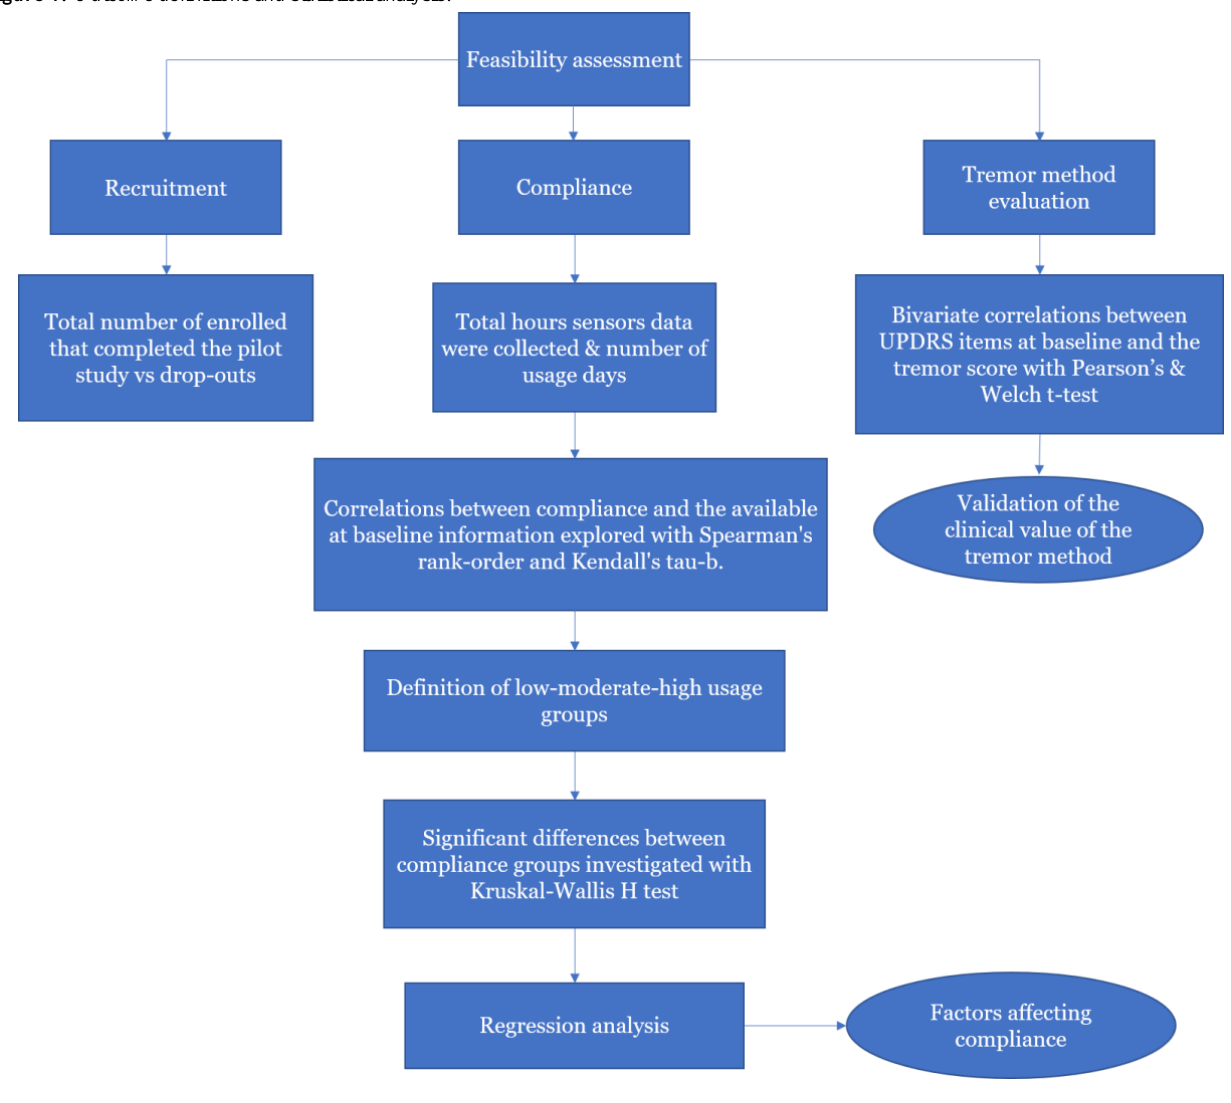
Figure 4. Outcome definitions and statistical